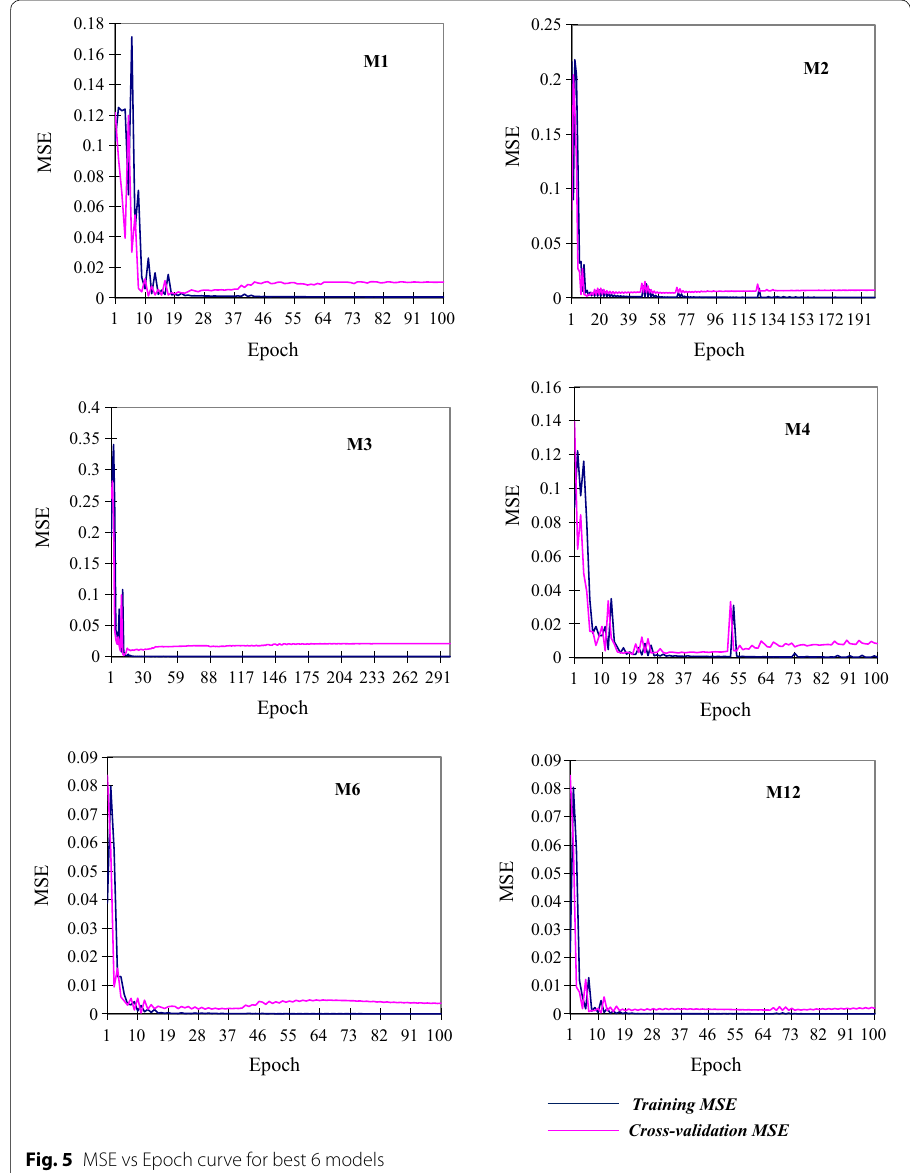
Fig. 5 MSE vs Epoch curve for best 6